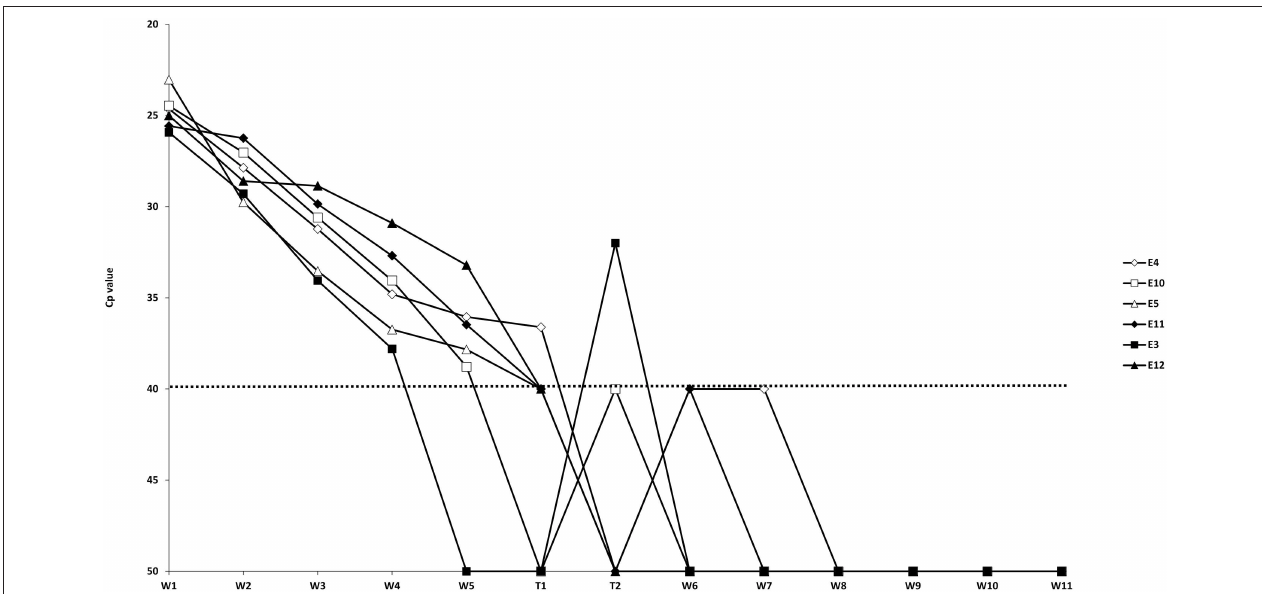
FIGURE 2 | RT-qPCR results of the wash step (W) 5–8, including both trypsin treatments and the embryos (E) after all washing steps. The percentage of positives are represented per wash/trypsin treatment group (as defined in Table 1 ).